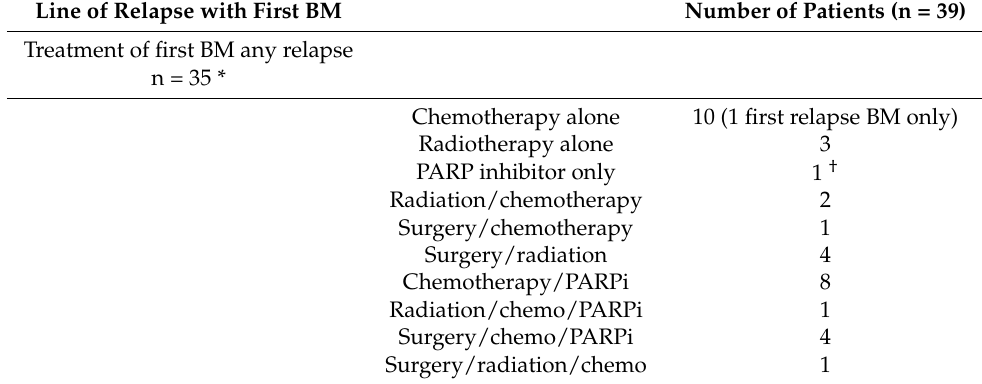
Table 2. Cont. Line of Relapse with First BM Number of Patients (n = 39) Treatment of first BM any relapse n = 35 * Chemotherapy